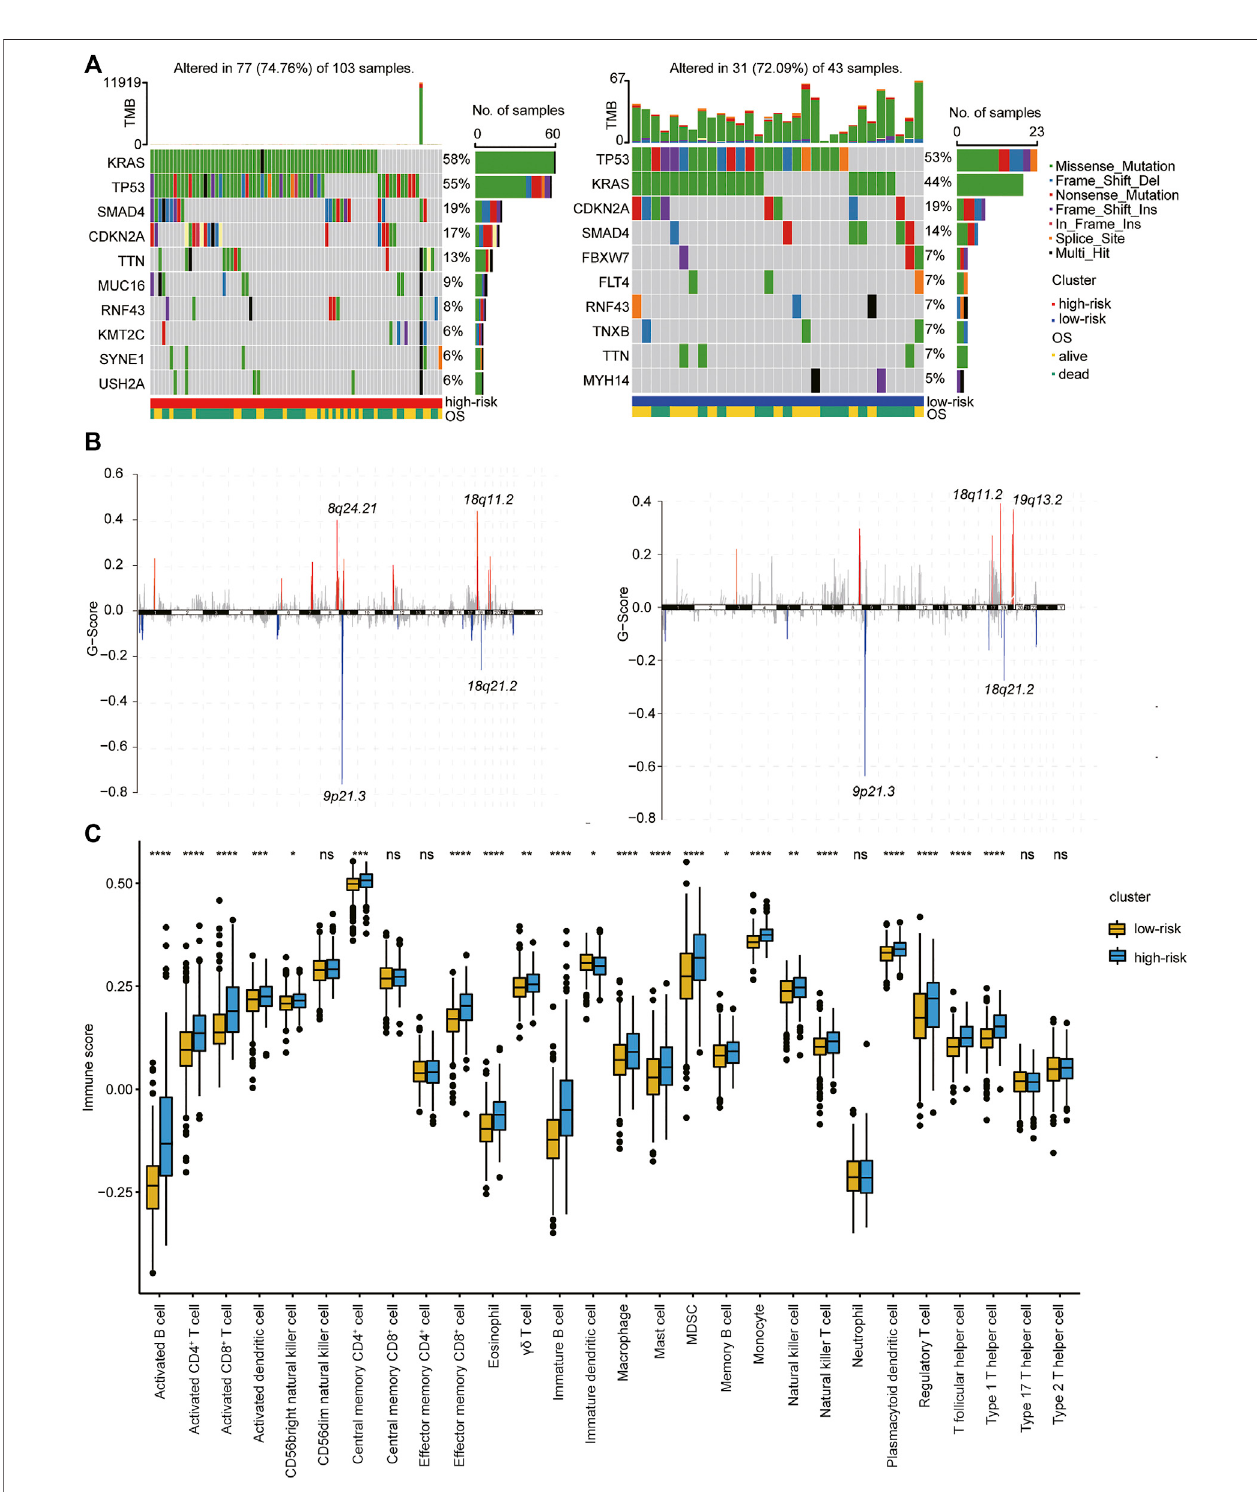
FIGURE 6 | Association of type 1 T helper cell – related signature-based risk score with gene mutations in PDAC patients. (A – B) The distribution of gene mutations (A) and missing copies (B) between high-/low-risk score clusters (Left: high risk cluster; right: low risk cluster). (C) The proportion of immune cell in fi ltration between different clusters. p -value was calculated with Wilcoxon test. Abbreviations: OS, overall survival.